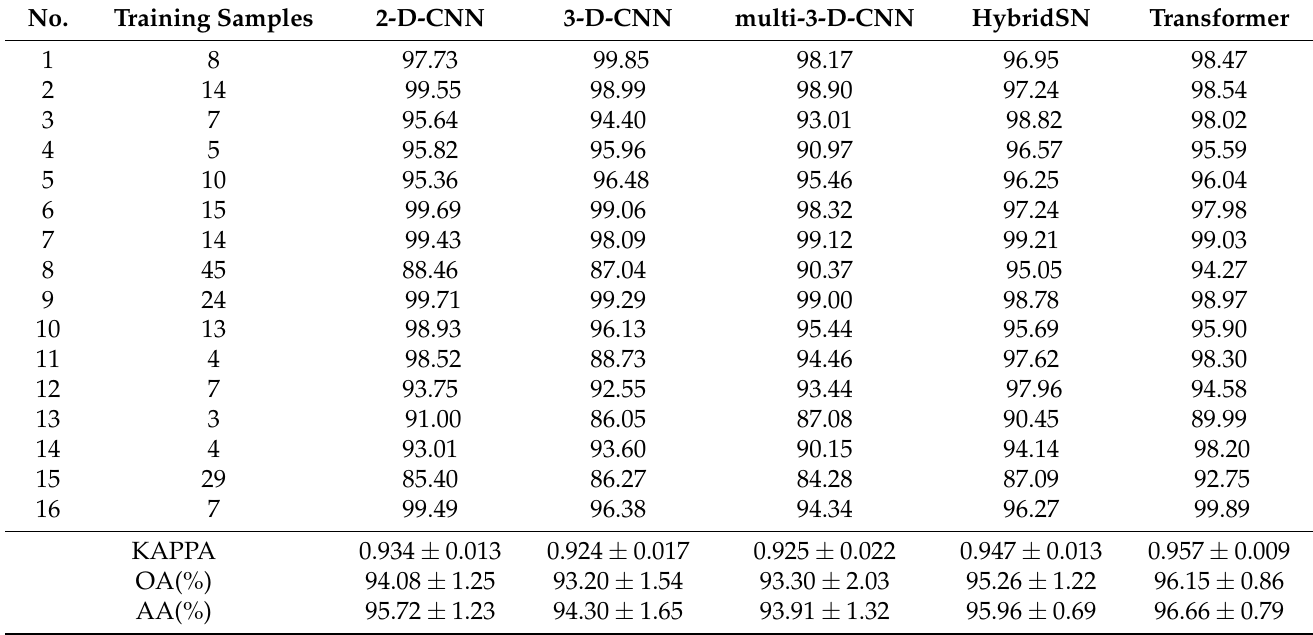
Table 9. Classification results of different models in Salinas.